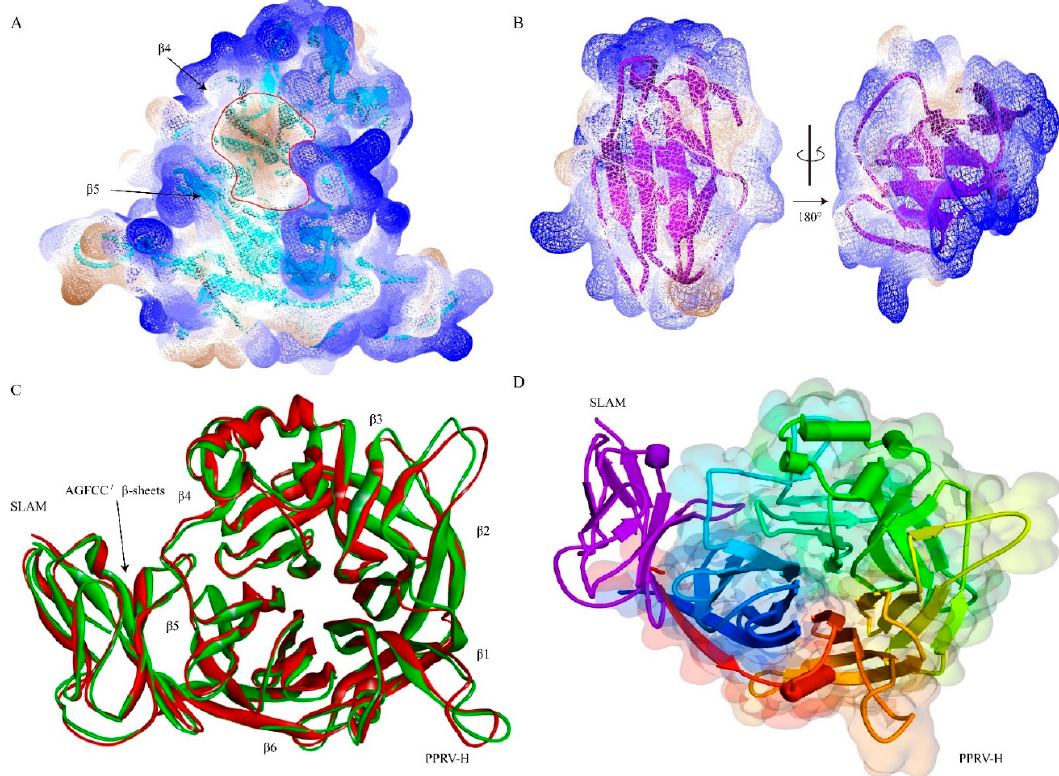
Figure 1. Cartoon and solvent drawing of the predicted PPRV H-SLAM complex. The complexes of the H protein’s six-bladed β -propeller head domain and the receptor SLAM V-like were built, in which β 4– β 6 of the head domain and the typical β -sandwich structure of the V domain were interacting surfaces. ( A and B ) show the analysis of the hydrophobicity of PPRV H and sheep SLAM, indicating that there was a strong hydrophobic groove between β 4– β 6 on the H head domain, and the surface on the sheep SLAM had stronger hydrophobicity. ( C ) A structure comparison revealed that the PPRV H-sheep SLAM and PPRV H-human SLAM complexes are very similar. ( D ) Interaction patterns between PPRV H and human SLAM.